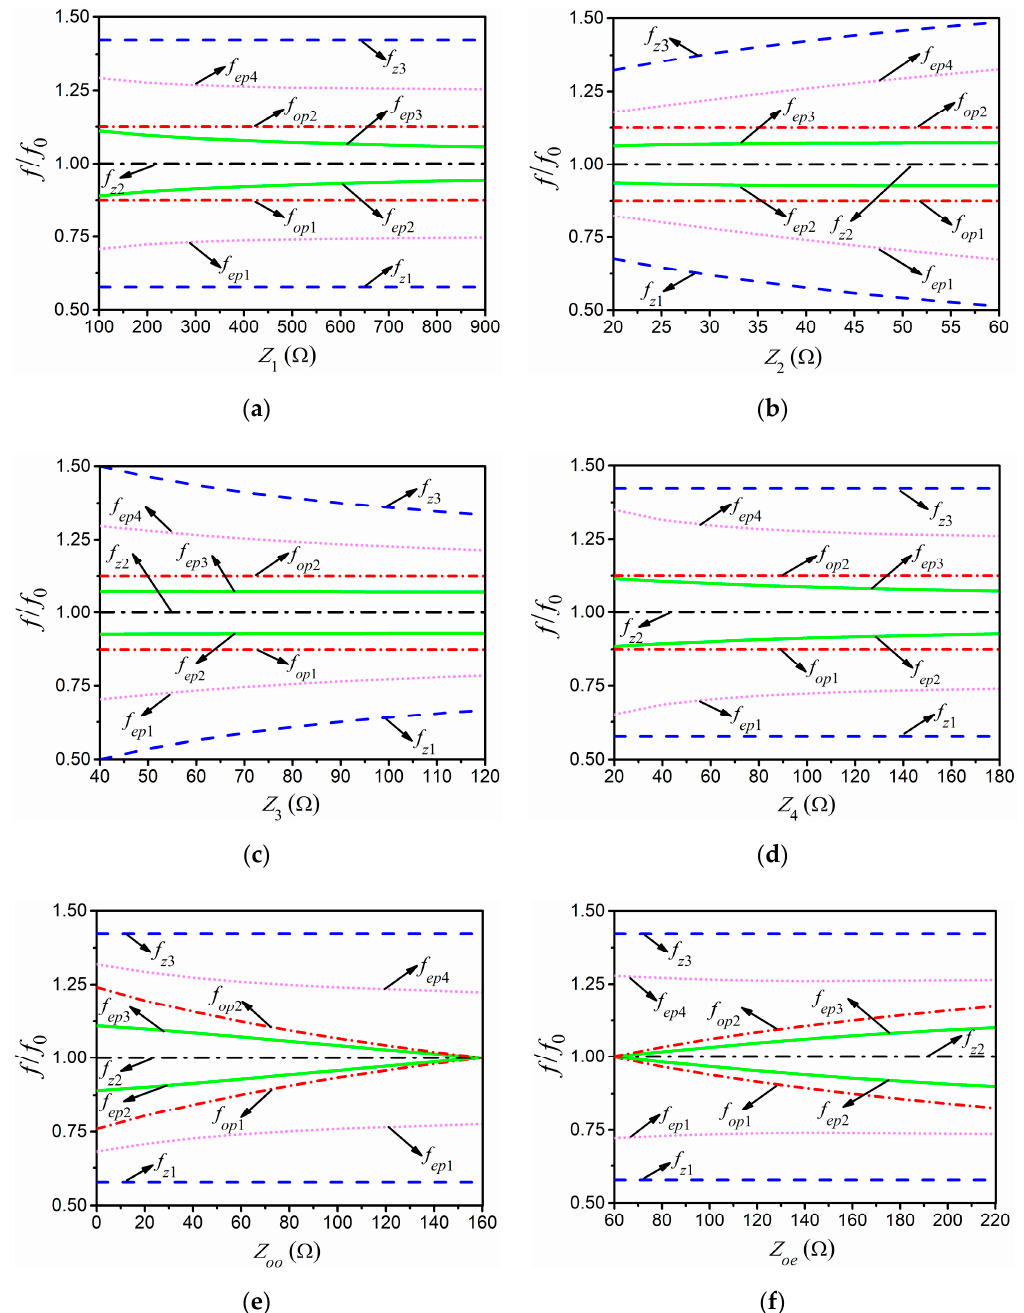
Figure 3. Transmission poles/ transmission zeros (TPs/TZs) with respect to varied characteristic impedances of ( a ) Z 1 ; ( b ) Z 2 ; ( c ) Z 3 ; ( d ) Z 4 ; ( e ) Z oo ; ( f ) Z oe (The reference parameters are: Z 1 = 500 Ω , Z 2 = 40 Ω , Z 3 = 80 Ω , Z 4 = 160 Ω , Z oo = 63 Ω , Z oe = 160 Ω ).